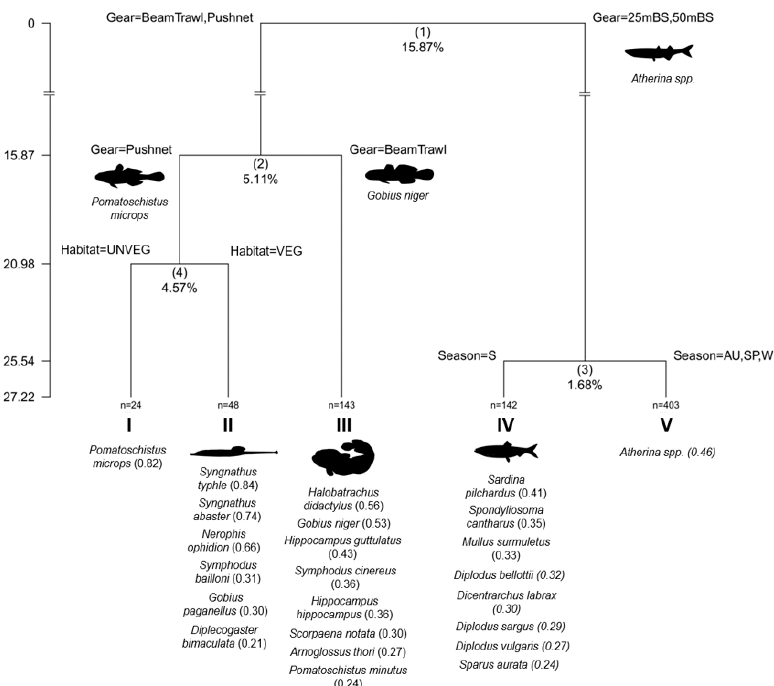
Figure 4. Multivariate regression tree for standardized species abundance data. Discriminant species (species that contributed the most to the variance explained in each node) are shown within the tree. Indicator species for each cluster (I–V) are represented together with their indicator values between brackets (IndVal ≥ 0.2). Overall, five distinct assemblages were identified, each one with a different set of indicator species. The first and second clusters were defined by samples obtained only with the Riley push net; the first group (I) is dominated by the common sand goby ( Pomatoschistus microps ) in sandy/muddy grounds; and the second group (II) contains three species of pipefish ( Syngnathus typhle , S. abaster and Nerophis ophidion ), Baillon’s wrasse ( Symphodus bailloni ), rock goby ( Gobius paganellus ) and the two-spotted clingfish ( Diplecogaster bimaculata ) in seagrass habitats. The third assemblage (III) is defined by species captured with beam trawl and the analysis did not separate at the habitat level, with toadfish ( Halobatrachus didactylus ), two goby species (black goby, Gobius niger , and sand goby, Pomatoschistus minutus ), two seahorse species ( Hippocampus guttulatus and H. hippocampus ), the grey wrasse ( Symphodus cinereus ), the small red scorpionfish ( Scorpaena notata ), and the flatfish Arnoglossus thori representing the indicator species for this assemblage. The last two groups (IV and V) were classified by samples collected both with the 25-m and 50-m beach seines, and the only split was defined by season. The summer assemblage was dominated by five sea bream species (black seabream, Spondyliosoma cantharus , Senegal seabream, Diplodus bellottii , White seabream, D. sargus , two-banded seabream, D. vulgaris , and gilt-head seabream, Sparus aurata ), European pilchard ( Sardina pilchardus ), striped red mullet ( Mullus surmuletus ) and the European bass ( Dicentrarchus